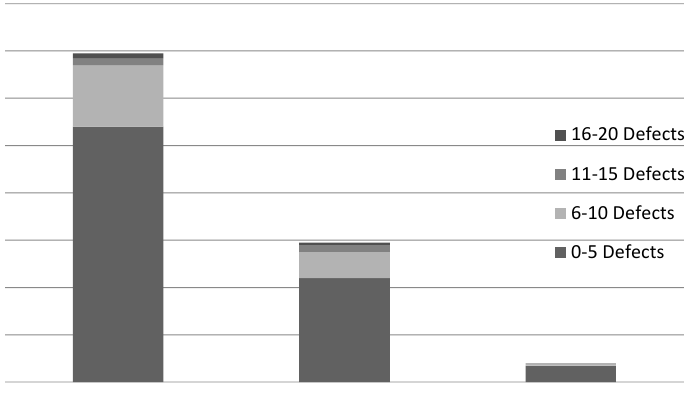
Figure 4. The use of independent building inspectors and number of